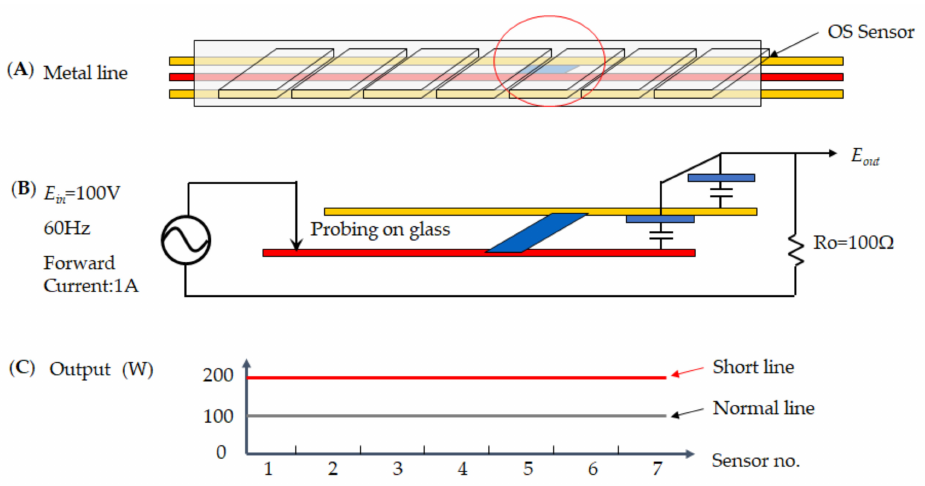
Figure 8. A short defect illustrates the electrical signal for TFT, which ( A ) metal line, ( B ) measurement voltage, and ( C ) power